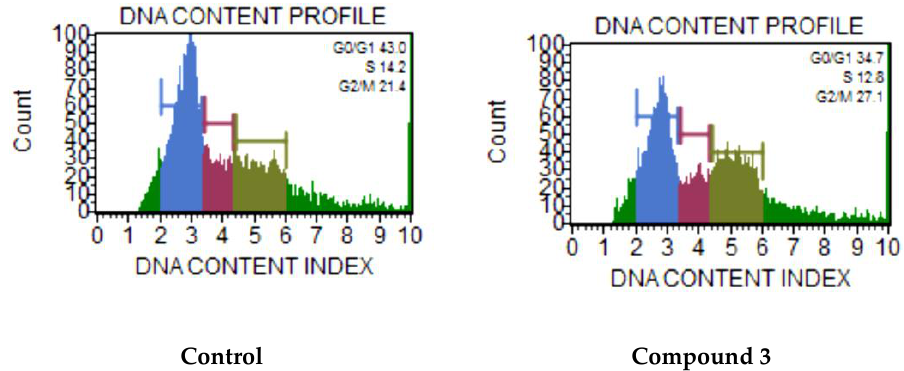
Figure 7. Cell cycle of HCT-116 cancer cells after treatment with compound 3 at μM after 24 h. Concentration of compounds 2 × IC 50 .